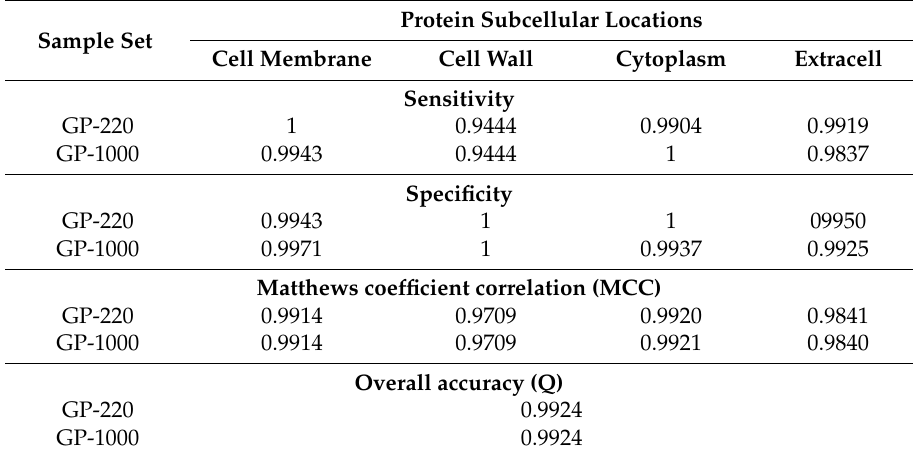
Table 3. The values of evaluation criterion with the proposed method for the Gram-negative.